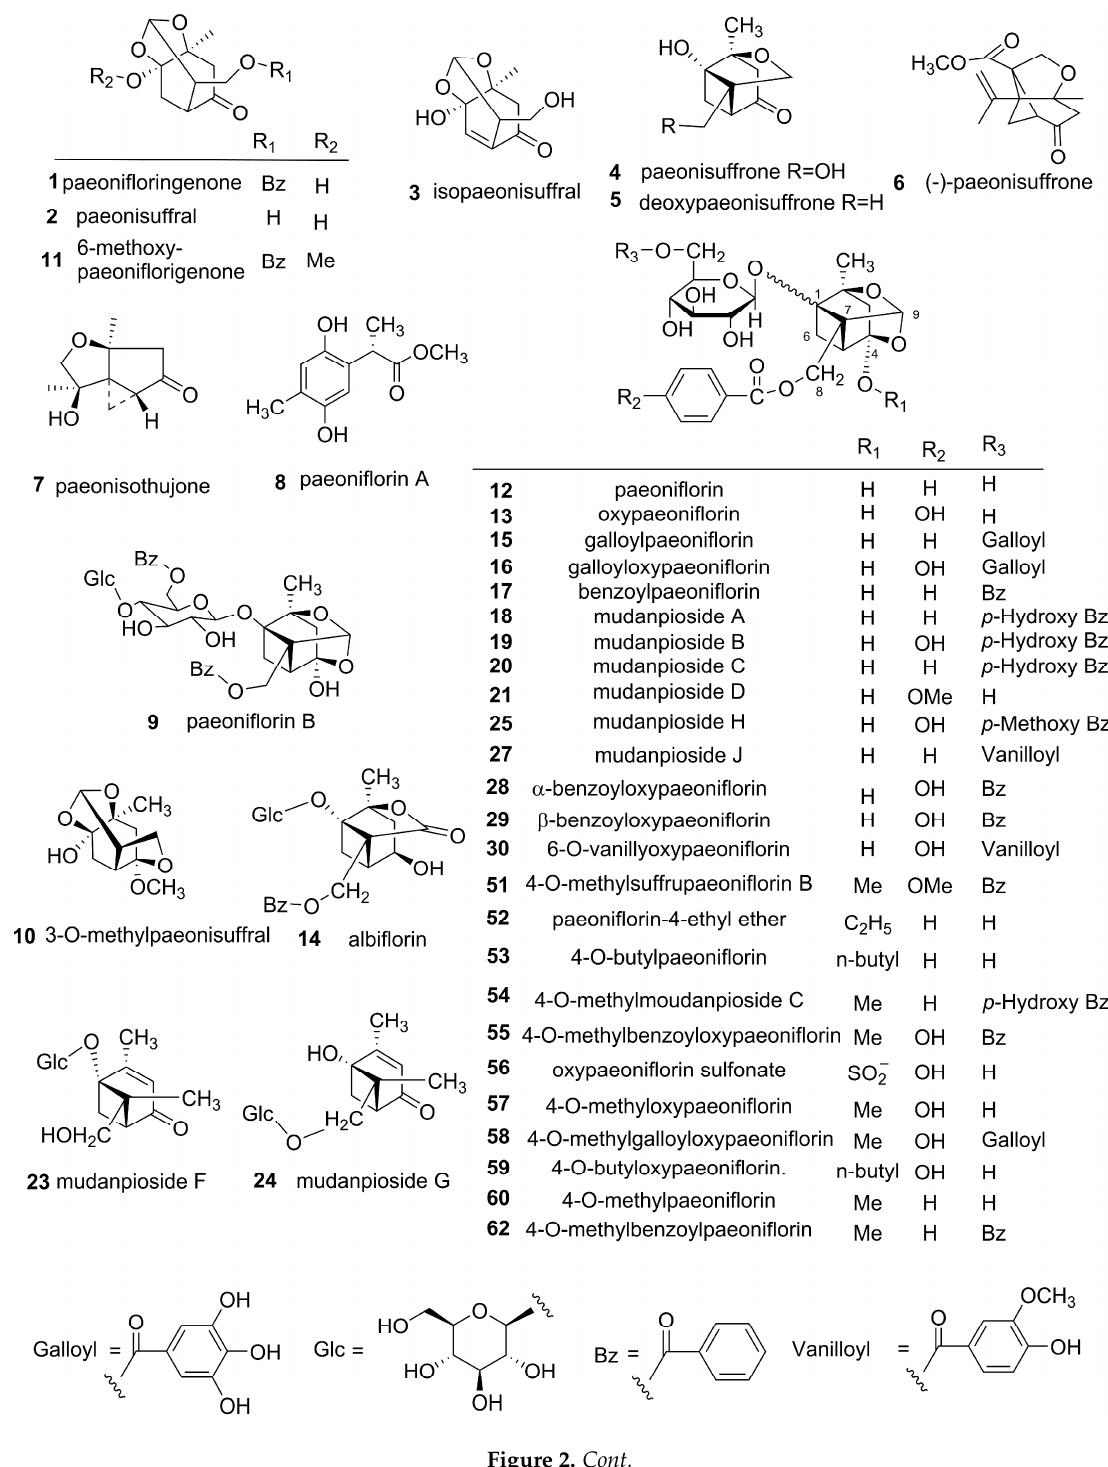
Figure 2. Cont. Figure 2.